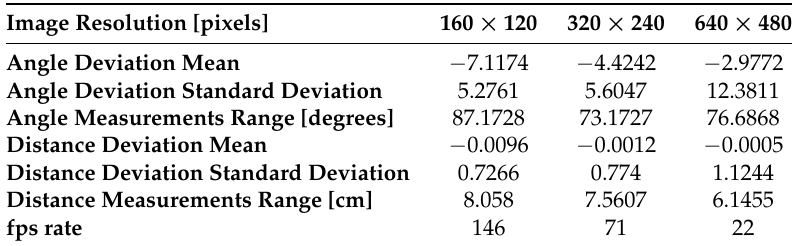
Table 7. Image resolution variation results summary with a 30 × 10 pixels size rectangular kernel, and a linear speed of 0.21 m / s